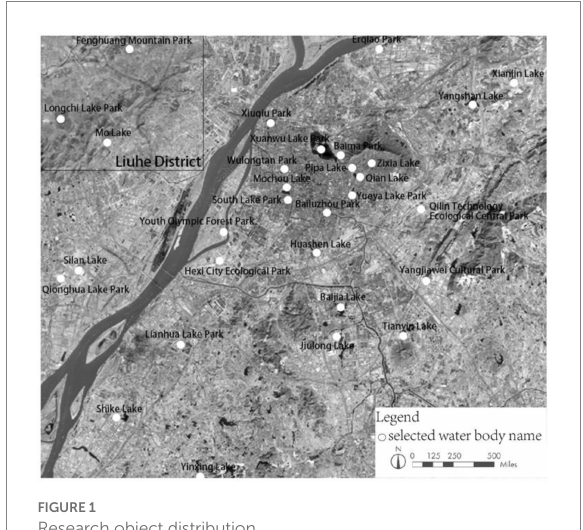
FIGURE 1 Research object